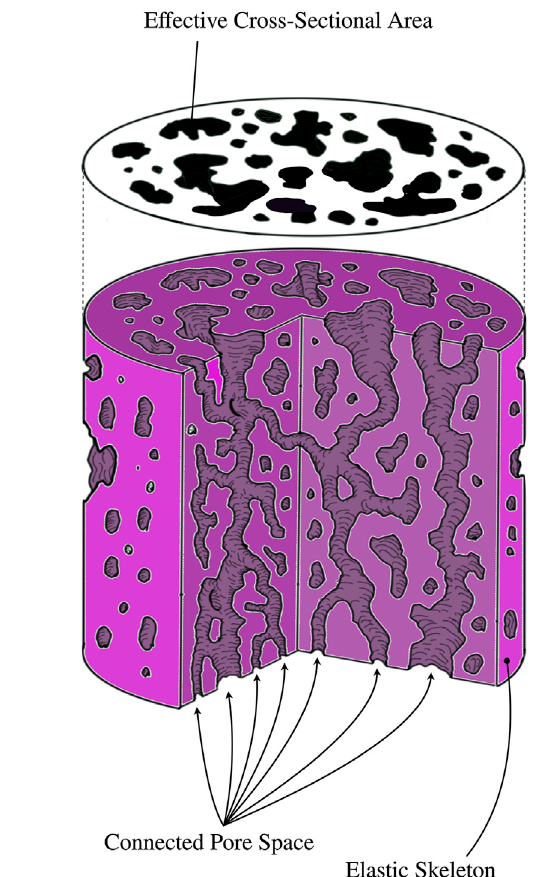
FIGURE 2 | The setup of one of the sand column experiments, from plate24, Figure3 ofDarcy ’ s1856 LesFontainesPubliquesdelaVilledeDijon [38]. Annotations have been added to clarify the origin of the physical quantities appearing in Eq. (1) . The piezometric heads h 1 and h 2 in the two piezometers on the right are measured using mercury. L is the length of the sand column, and A its cross-sectional area. In this setup the diameter of the column is 0.35 m, and the height of the column is 3.5 m. Δ V f / Δ t is the rate at which fl uid volume is leaving the column, measured by observing the rise of